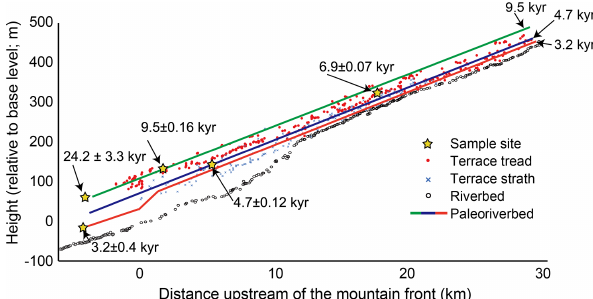
Figure 7. Simplified model for Beida River incision since 9.5kyr. The surveyed terrace treads and the paleoriverbeds we projected are corrected for tectonic uplift and therefore slightly deviated from the sample locations. The time period between 24.2 and 9.5kyrBP is not included in this model because the river was mostly incising into the T1 terrace fill, and therefore the incision of the foreland and hinterland should be synchronous.